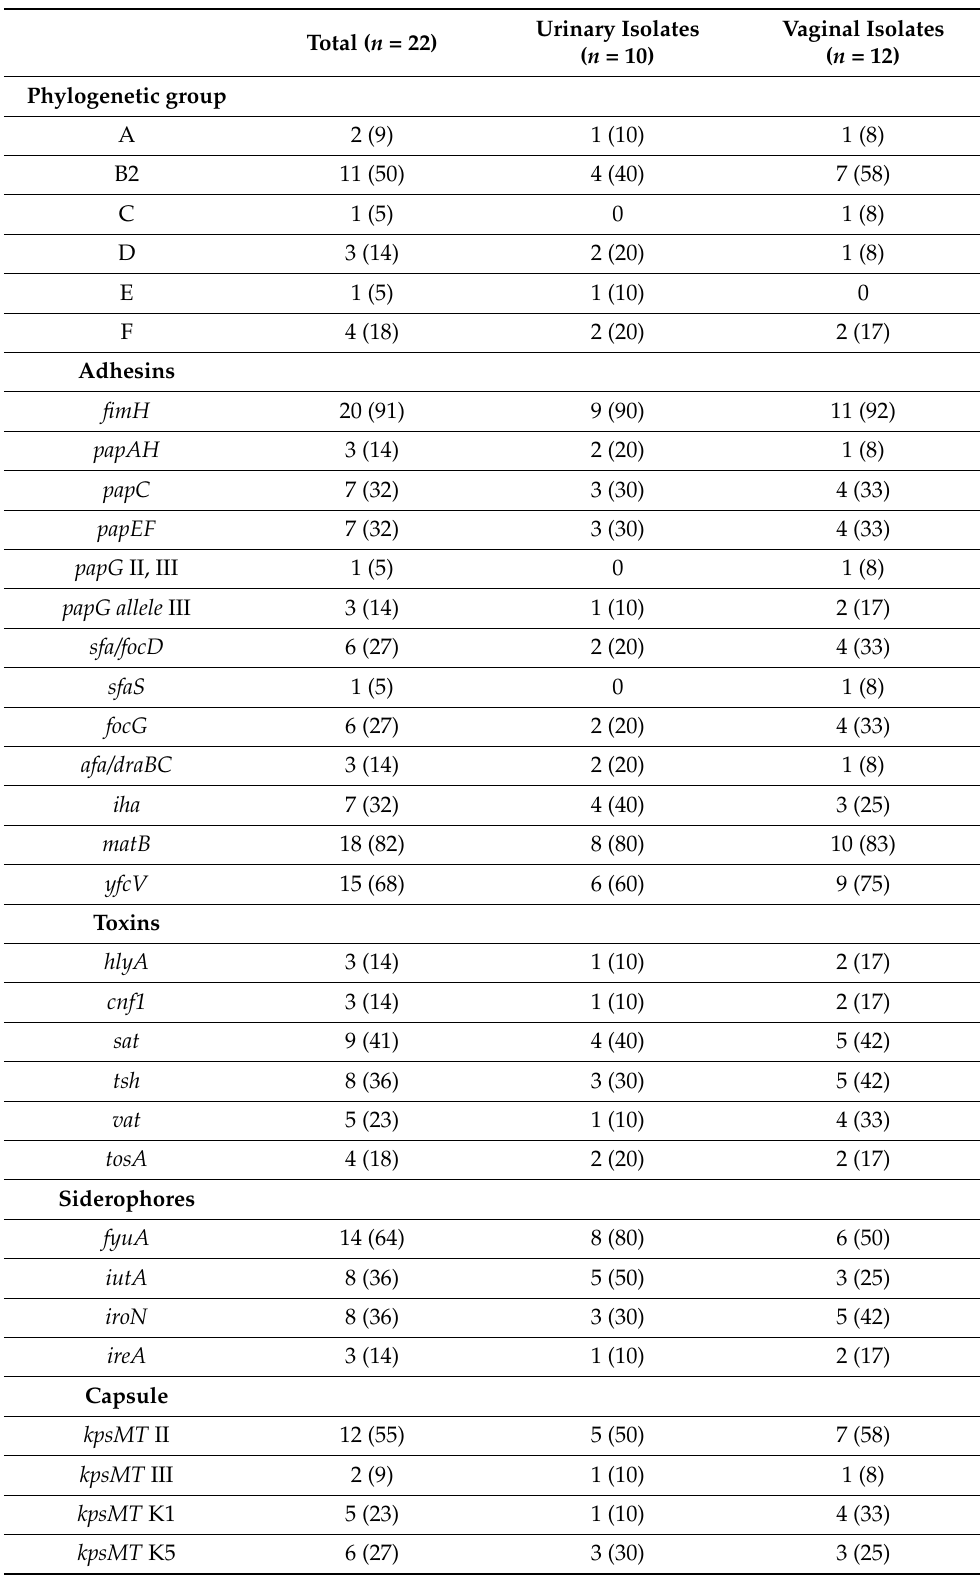
Table 2. Detection and prevalence (%) of phylogenetic groups and 41 putative virulence genes among 22 unique E. coli strains per each sample